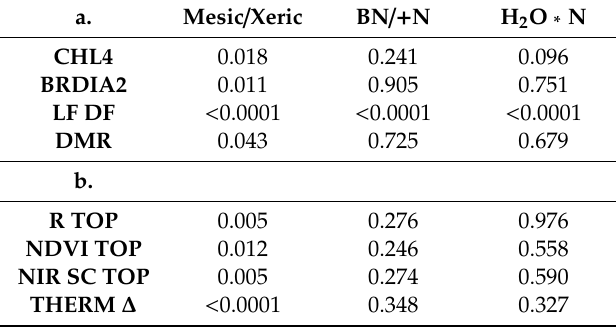
Table 1. Crown morphological (a) and spectral (b) traits with significant di ff erences from 2-way ANOVAs: (N level (background (BN), and amended N ( + N); nested within water availability level, mesic / xeric). H 2 O * N indicates the significance of the interaction term. p -values are listed in columns of comparisons. Acronyms for traits given in Appendix